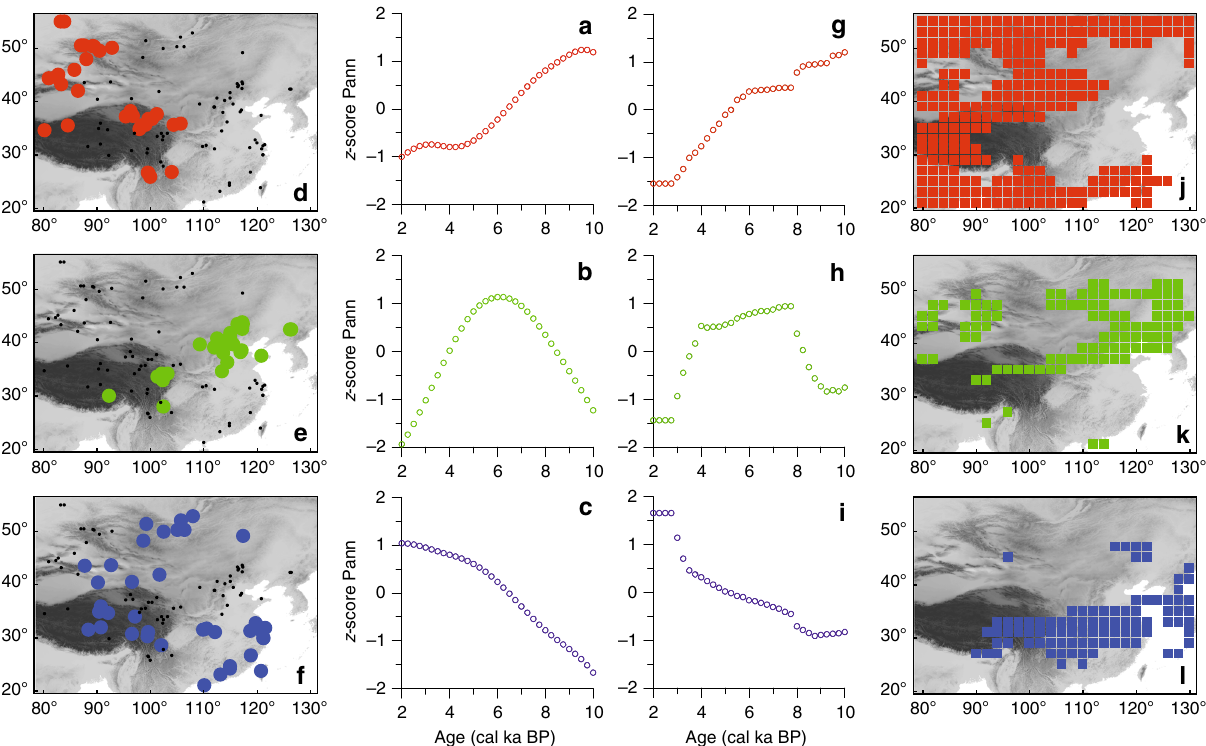
Fig. 1 Holocene precipitation patterns for eastern Asia derived from clustering of Holocene time-series of pollen-inferred and simulated annual precipitation. a – c (pollen-infered) and g – i (simulated) show temporal variations in the centers of each cluster, as derived from unsupervised fuzzy competitive learning (see Methods). d – f Show the spatial distribution of pollen-inferred time-series that have a membership degree >0.5 to a particular cluster. j – l Show the spatial distribution of simulated time-series that have a membership degree >0.5 to a particular